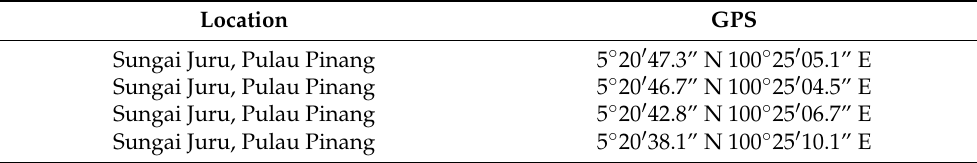
Table 1. GPS location list of sampling area sites.